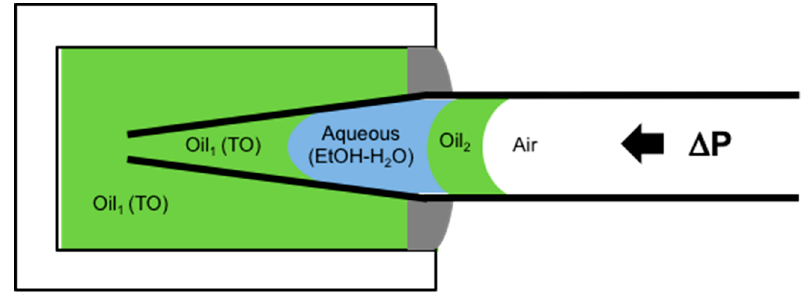
Figure 27. Schematic illustration of the equilibrium interfacial tension measurement of an oil-water interface in which one component is volatile [16,17]. In the set-up, the chamber is filled with the oil solution (Oil 1 ) Triolein. Then, the tapered micropipette, is prefilled with the same oil (Oil 2 ) and the water solution under investigation is also aspirated into the tip. The pipette is then inserted into the Oil 1 under positive applied pipette-pressure in order to maintain the water and Oil 2 plug inside the tapered micropipette. The Oil 2 solution is used to avoid evaporation of water solution. Once again, control of applied pipette pressure drives the interface meniscus to measurable radii in the tapered pipette, and the application of the Laplace equation, Equation (5), gives the interfacial tensions.